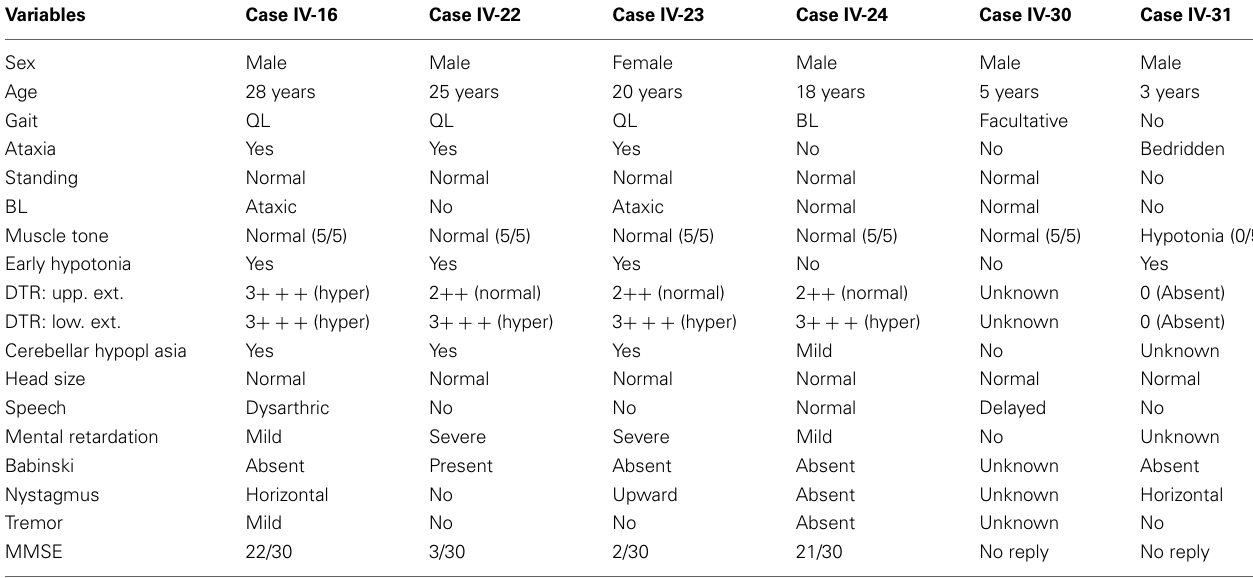
Table 1 | Clinical characteristics of the UTS Type-II and other